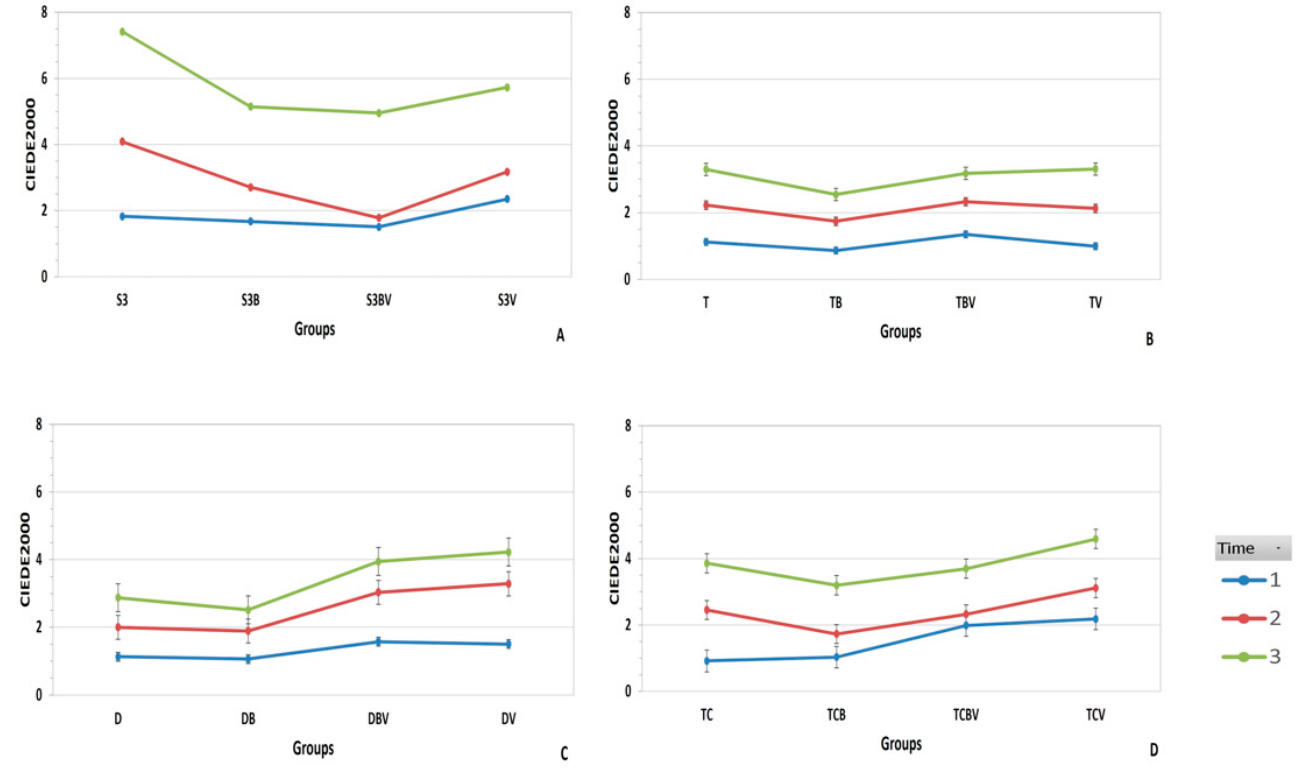
Figure 3. Mean ∆ E 00 (six staining solutions) interaction for each group and time: T1 (24 h); T2 (7 days); T3 (30 days). ( A ) bis-acryl (Structur 3); ( B ) PEMA (Trim); ( C ) PMMA (DuraLay); and ( D ) PMMA blocks for CAD/CAM (TelioCAD).